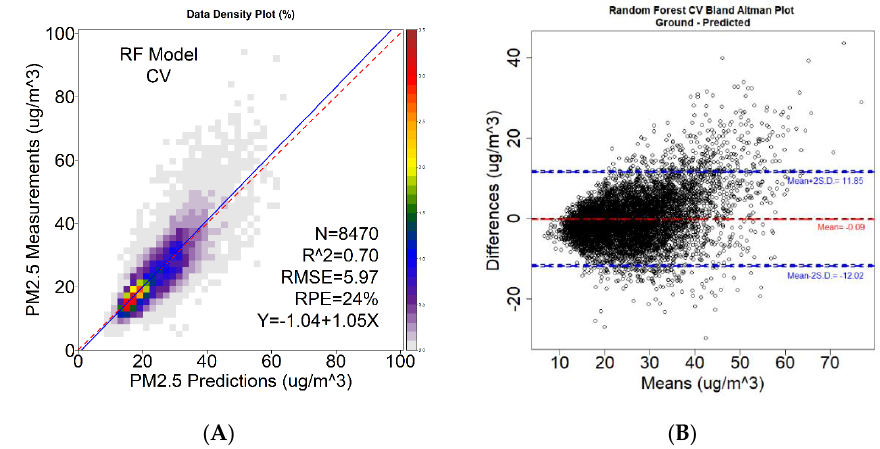
Figure 3. ( A ) Density plot of ground and predicted PM 2.5 measurements in µg/m 3 based on the cross- validation of the Random Forest model. ( B ) Bland – Altman plot of differences between ground and cross-validation of the Random Forest model. ( B ) Bland–Altman plot of differences between ground predicted PM 2.5 in µg/m 3 against the means of each pair. This plot shows good agreement as 94.5% of and predicted PM 2.5 in µ g/m 3 against the means of each pair. This plot shows good agreement as observation pairs fall within 2 standard deviations of the mean difference. 94.5% of observation pairs fall within 2 standard deviations of the mean